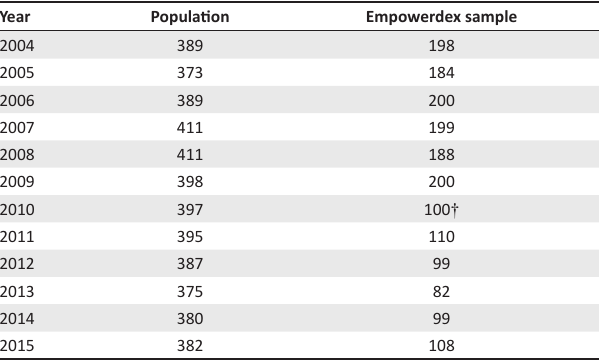
TABLE 3: Details on the population and